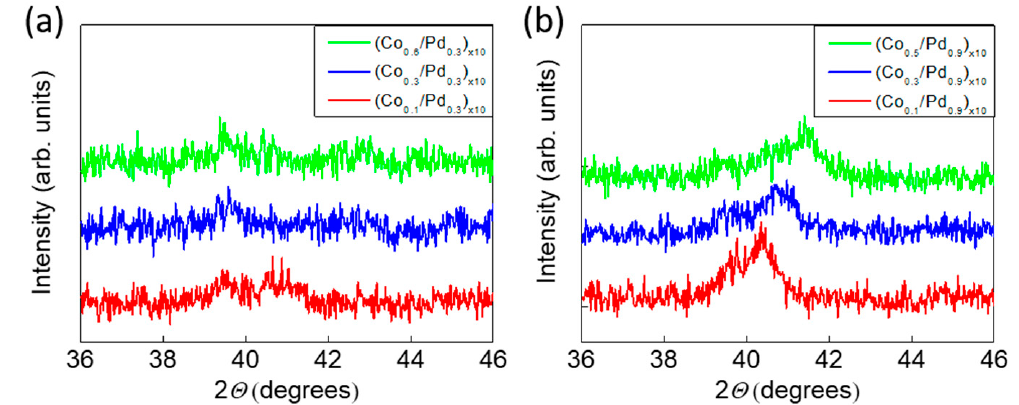
Figure 1. X-ray diffraction (XRD) ( θ -2 θ ) patterns corresponding to samples of ( a ) series 1 and ( b ) series 2. A small peak at ~39.5° corresponds to the substrate.